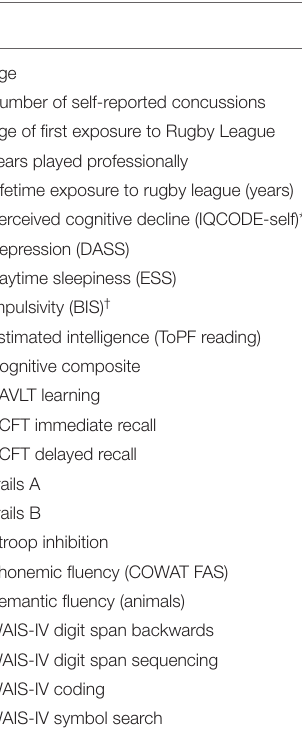
TABLE 3 | Spearman bivariate clinical-anatomic correlations in retired Rugby League players ( n = 41).